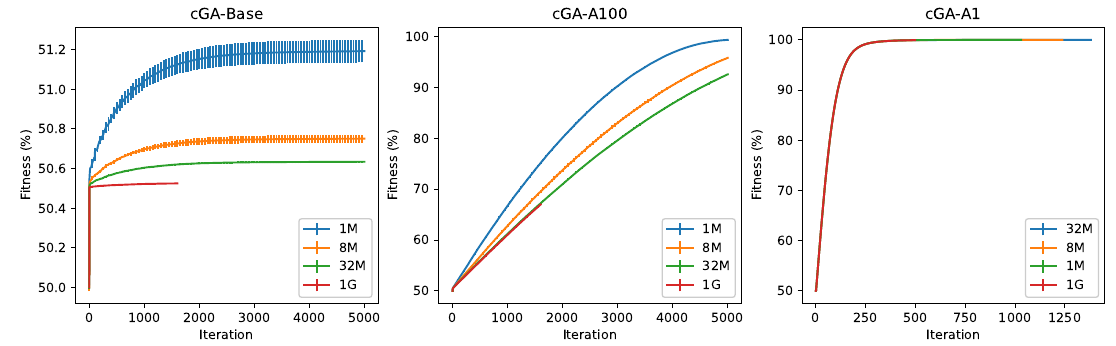
Figure 1. Best fitness value per iteration (mean ± std. dev. across 10 runs per algorithm) for the three binary cGAs on the OneMax problem in four different dimensionalities.